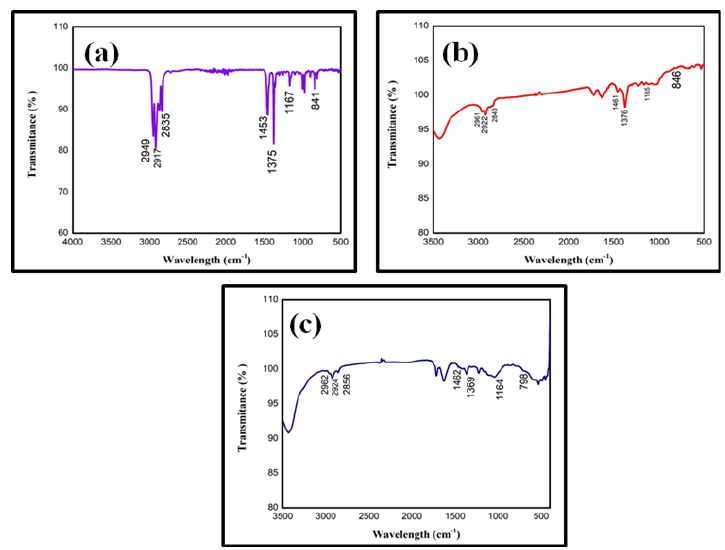
Figure 1. FTIR spectral graph of polypropylene. ( a ) Virgin polypropylene plastic film, ( b ) Poly- propylene microplastics, ( c ) Polypropylene microplastics in fish’s